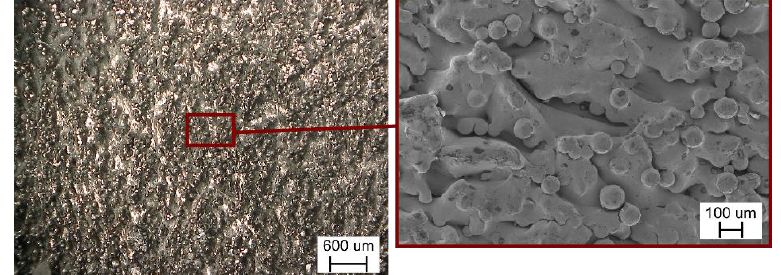
Figure 4. Surface morphology of an as-built sample.